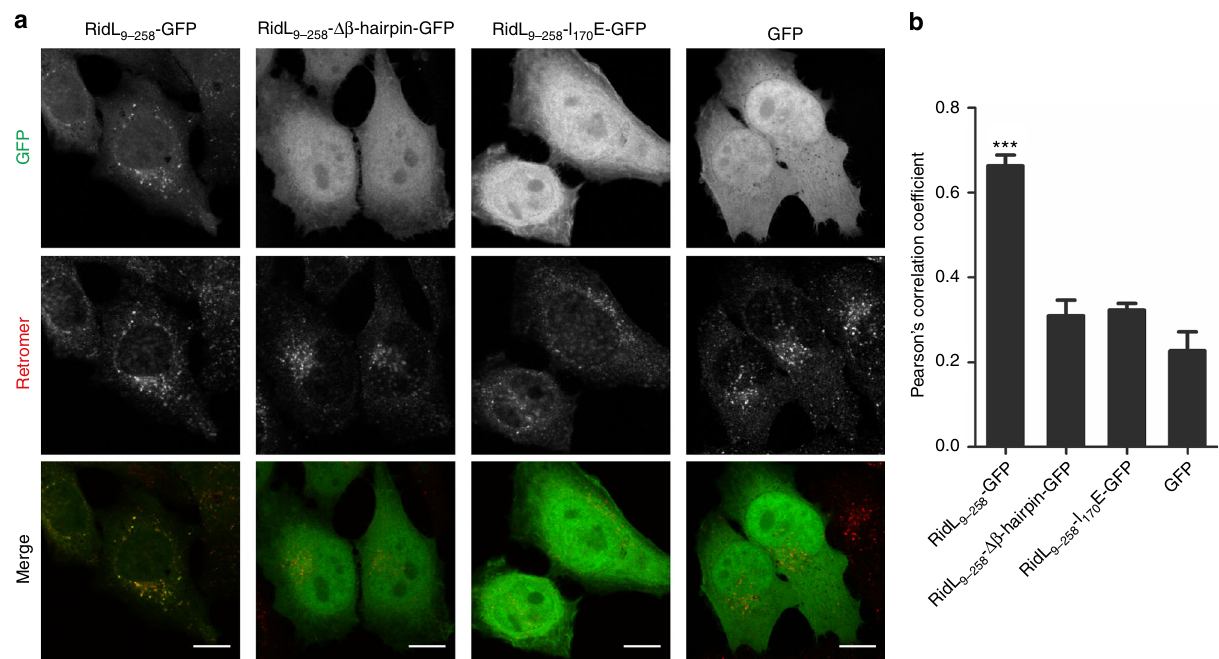
Fig. 2 The RidL 9-258 β -hairpin determines retromer binding of the fragment in cells. a HeLa cells were transiently transfected with vectors producing GFP- fusion proteins or GFP as indicated (green) and immuno-stained for the retromer (Vps26; red). Scale bar, 10 μ m. b Co-localization of RidL variants with retromer ( a ) was scored. The Pearson ’ s correlation coef fi cient was calculated in three independent experiments with at least 50 cells each (mean and standard deviation, SD, of the mean from each experiment; one way ANOVA; *** P <